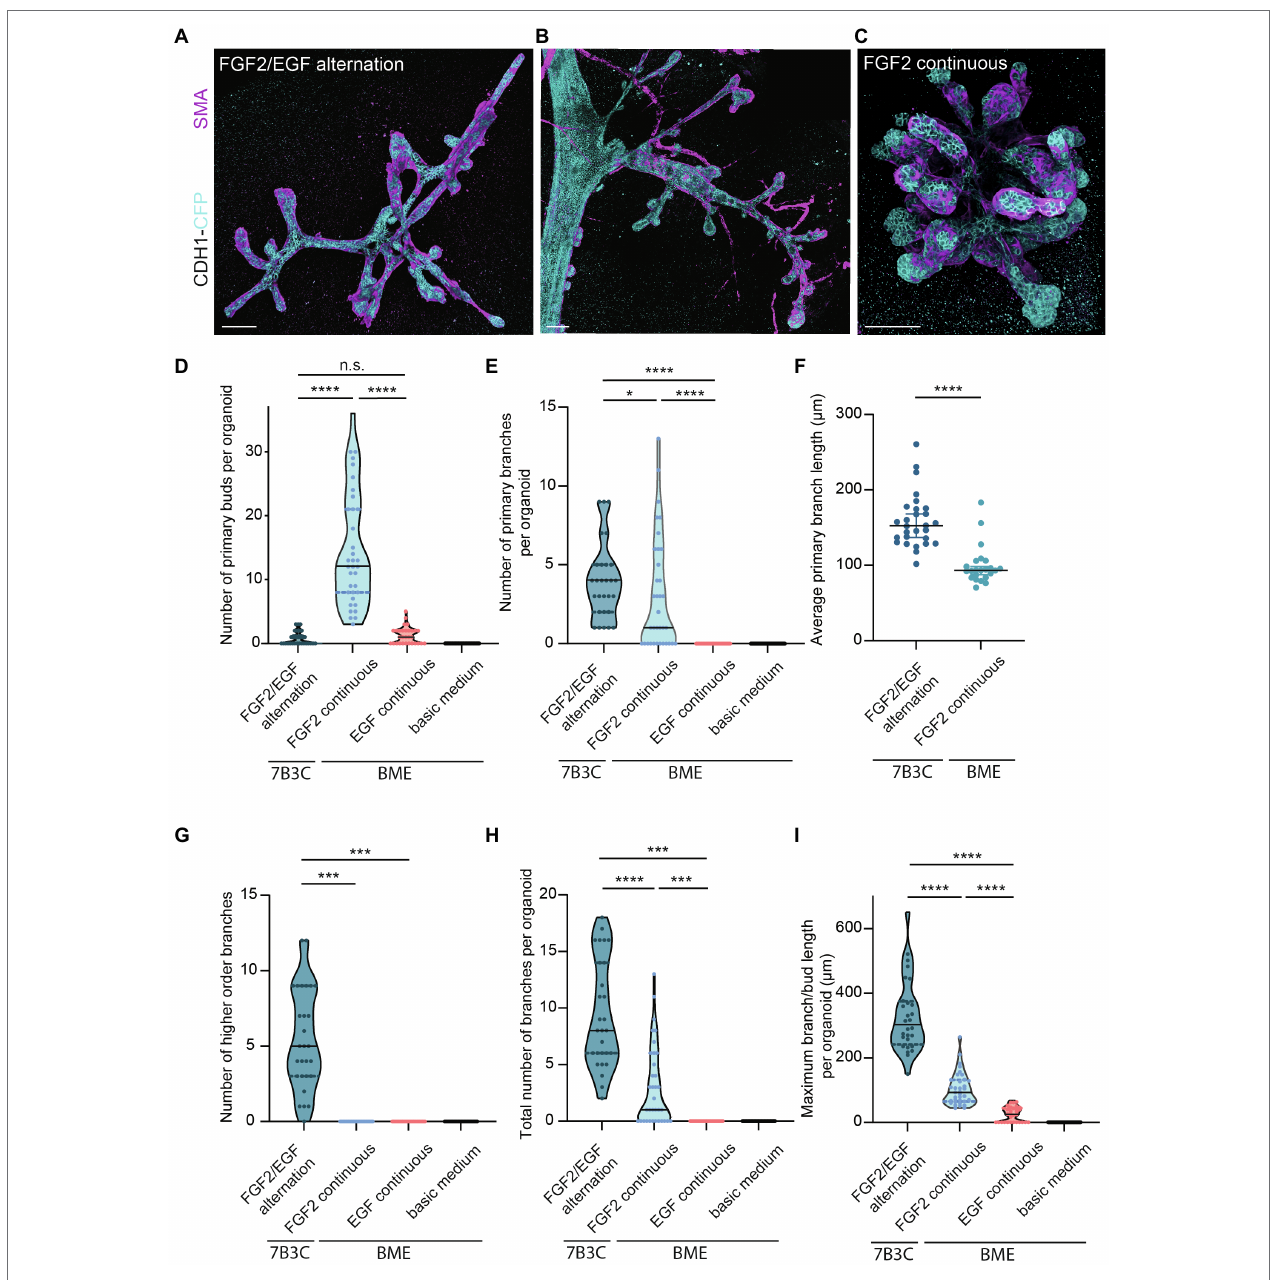
FIGURE 4 | Comparison of branching parameters between different mammary organoid culture conditions. (A) Representative 3D rendering of a branched mammary organoid obtained after 14 days in 7B3C with FGF2/EGF alternation treatment. (B) 3D rendering of a whole-mount mammary gland derived from a 10-week-old Cdh1-CFP female mouse. Note the morphological similarities with the mammary organoid depicted in (a). (C) Organoid grown in BME with medium supplemented with FGF2, resulting in the formation of budding structures. Cdh1-CFP is shown in cyan; smooth muscle actin labeling is shown in magenta. Note that not all buds are covered with myoepithelial cells. Scale bars represent 100 μ m. (D) Quantification of the number of primary buds per organoid, defined as structures <70 μ m, in the different culture conditions. Black lines indicate median value, and dotted lines indicate the 25th and 75th percentile. (E) Quantification of the number of primary branches per organoid defined as structures >70 μ m. Black lines indicate median value and dotted lines indicate the 25th and 75th percentile. (F) Comparison of average primary branch length per organoid between 7B3C alternation treatment conditions and BME with continuous FGF2 supplementation. Black lines indicate median value, and colored lines indicate 95% confidence interval. (G–I) Quantification of number of higher order branches (G) , total number of branches (H) , and maximum branch length (I) per organoid in the indicated culture conditions. All parameters were quantified at day 18 of culture for all conditions; data represent >30 organoids per condition derived from three experimental replicates. Significance was tested using Mann–Whitney test, * p ≤ 0.05, *** p ≤ 0.001, **** p ≤